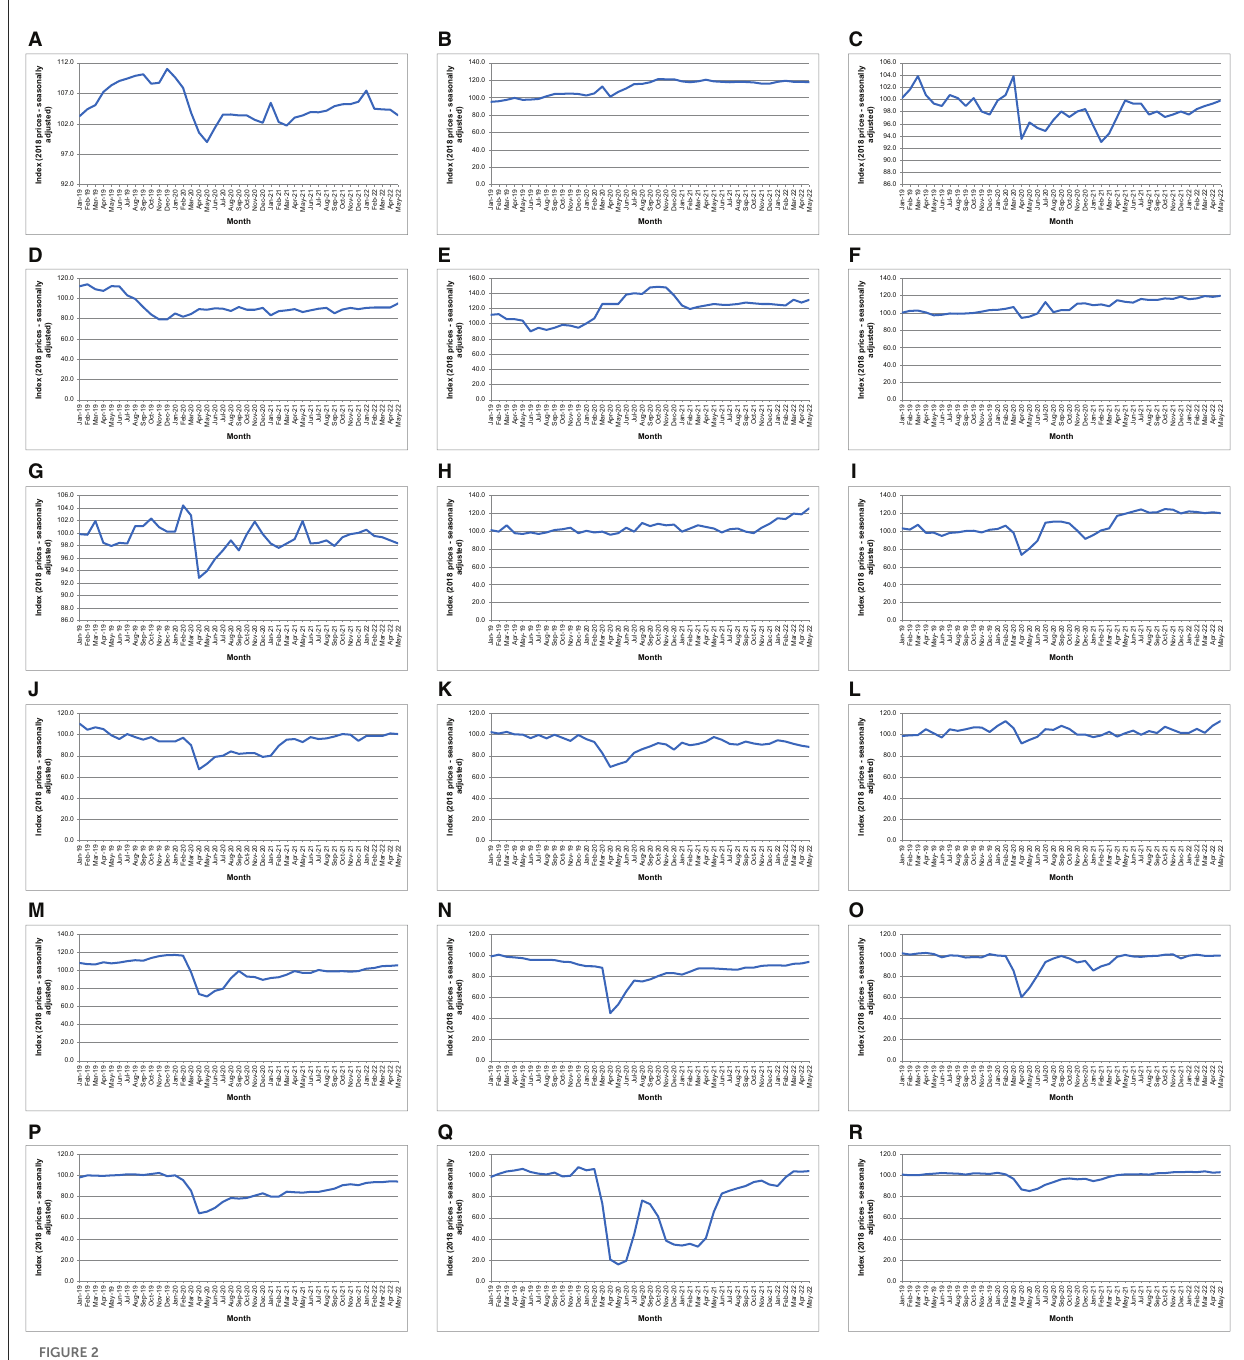
FIGURE2 Evolution of the gross domestic product by production sector. (A) Gross domestic product - Agriculture, fisheries and forestry. (B) Gross domestic product - Preserved meat and meat products. (C) Gross domestic product - Processed and preserved fish, fruit and vegetables. (D) Gross domestic product - Manufacture of dairy, vegetable and animal oils and fats. (E) Gross domestic product - Grain mill products, starches and starch products. (F) Gross domestic product - Bakery and farinaceous products. (G) Gross domestic product - Other food products. (H) Gross domestic product - Prepared animal feeds. (I) Gross domestic product - Alcoholic beverages and tobacco products. (J) Gross domestic product - Soft drinks. (K) Gross domestic product - Other manufacturing. (L) Gross domestic product - Energy supply, water and waste. (M) Gross domestic product - Mining and quarrying. (N) Gross domestic product - Construction. (O) Gross domestic product - Wholesale and retail trade and repairs. (P) Gross domestic product - Transport and storage. (Q) Gross domestic product - Accommodation and food service activities. (R) Gross domestic product - Other